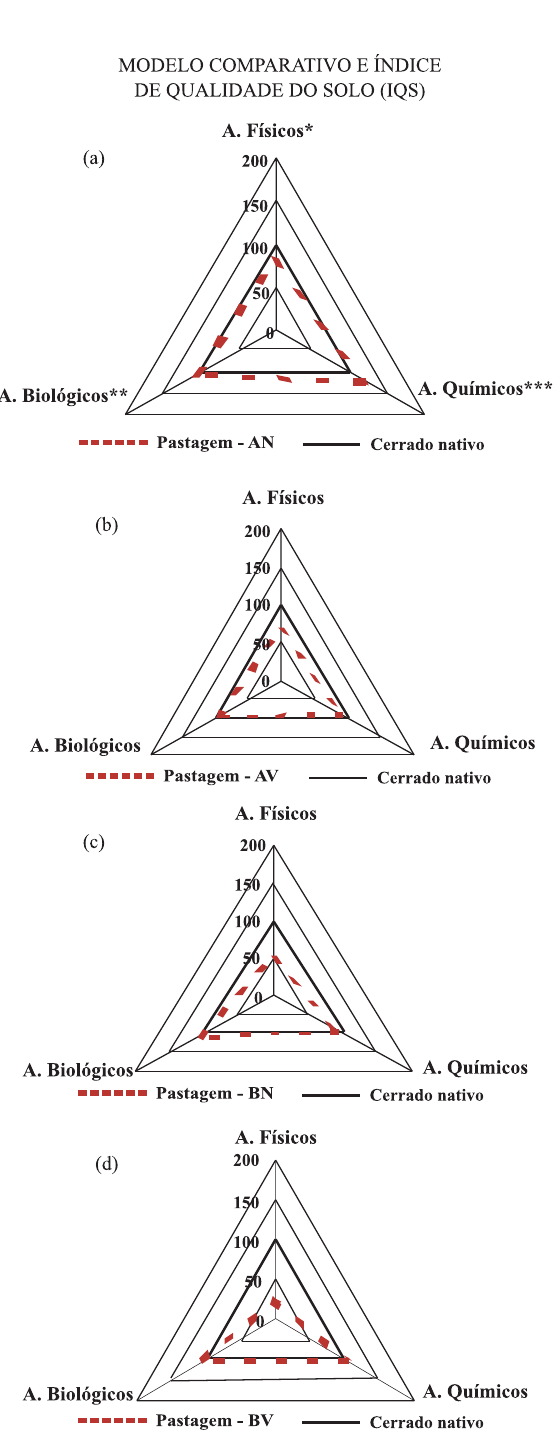
Figura 1. Diagramas comparativos da qualidade do solo, com diferentes tempos de uso, entre as áreas de pastagens e o Cerrado nativo. *: densidade do solo, porosidade e resistência do solo à penetração; **: matéria orgânica; ***: capacidade de troca de